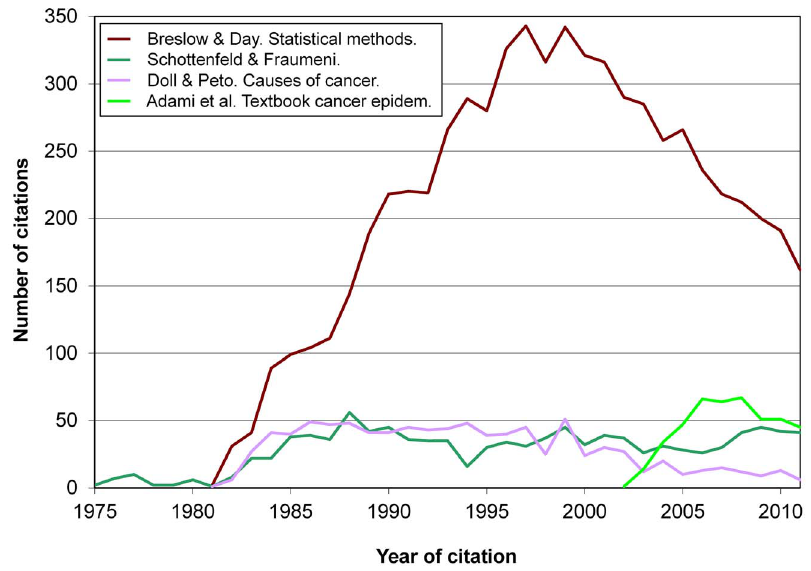
Figure 7. Citations to 5 books on cancer epidemiology (total, 8,991 citations).